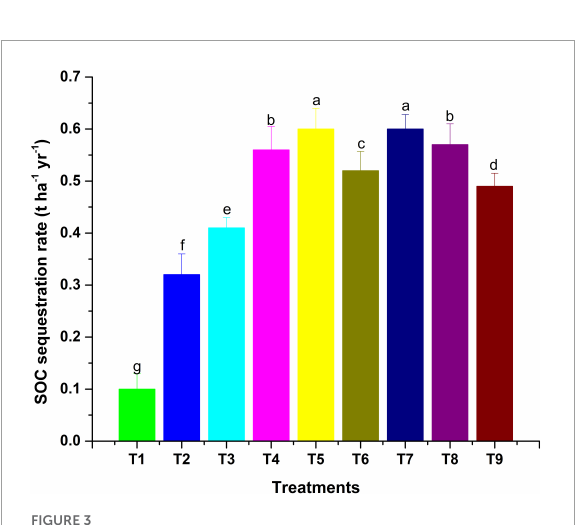
FIGURE3 The SOC seq. rate as influenced by MI-mediated nutrient management. Different letters in alphabetical orders in figure are generally assigned to indicate the significantly different values at p < 0.05 according to Duncan’s multiple-range test for separation of